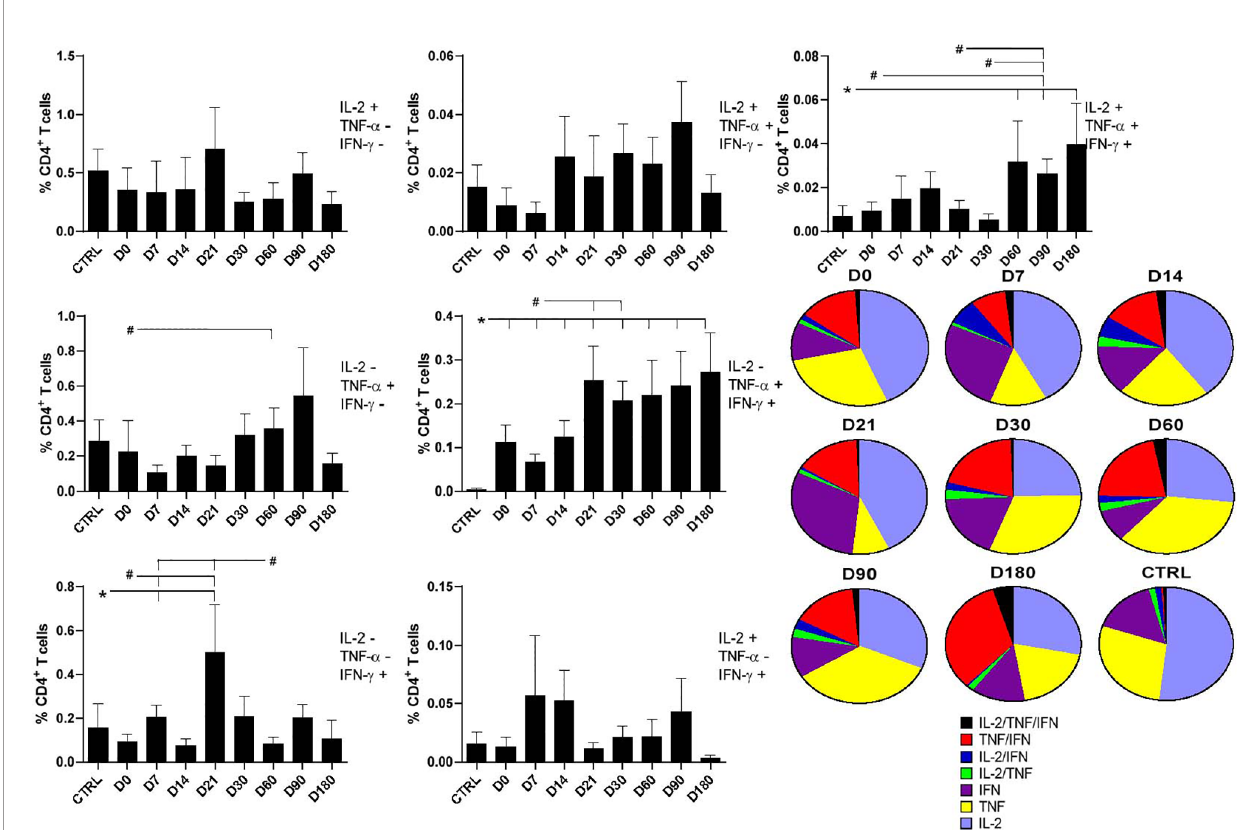
FIGURE 2 | Distinct quality of CD4 + T in follow-up of visceral leishmaniasis (VL) treatment and of endemic control subjects. Evolution of the frequencies of CD4 T cells producing one cytokine (IL-2, TNF- a , or IFN- g ), and any combination of two or all three cytokines along the time. Each frequency was recorded after background subtraction of cells incubated without antigen [soluble Leishmania antigen (SLA)]. Results are expressed as means+SE, with asterisks and horizontal lines indicating signi fi cant differences between times of treatments and healthy controls as disclosed by the Mann – Whitney method. Hashtags show signi fi cant differences between times of treatment as determined by the Wilcoxon matched-pairs rank statistical